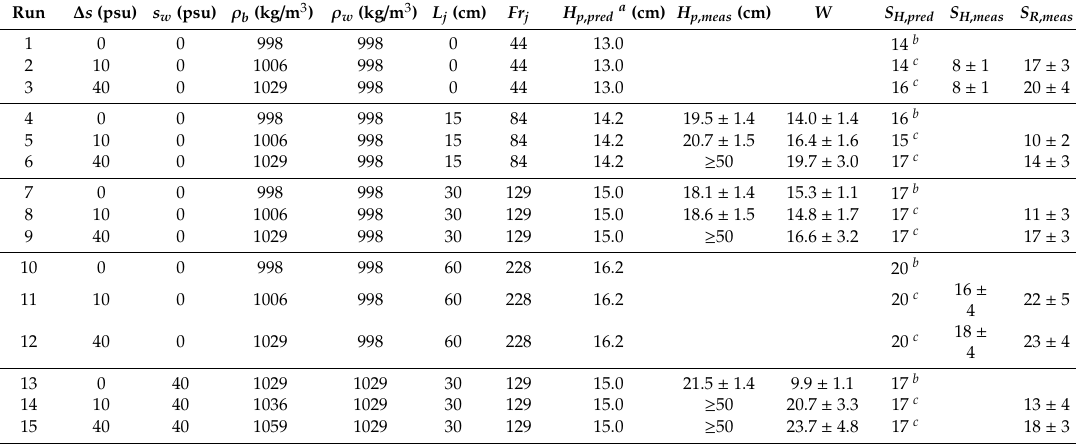
Table 2. Experimental parameters for unconfined plunging